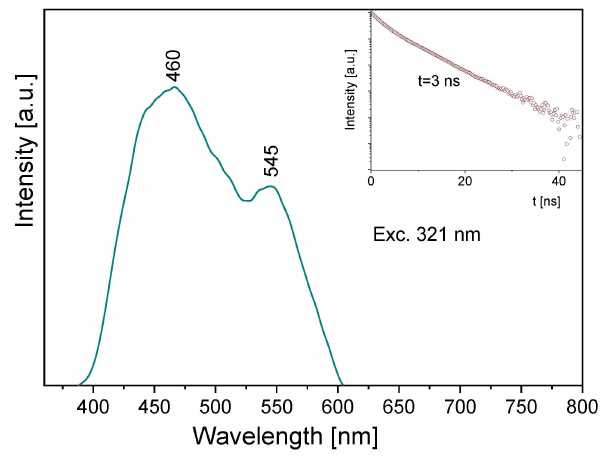
Figure 10. The emission spectrum of the TPa-NH 2 molecule. Inserts show the emission lifetime for the TPa-NH 2 molecule excited at 321